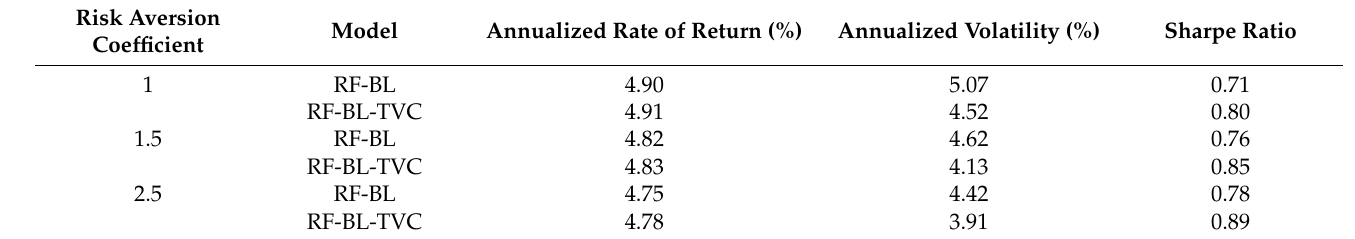
Table 5. The annualized rate of return and annualized volatility of RF-BL model and RF-BL- TVC